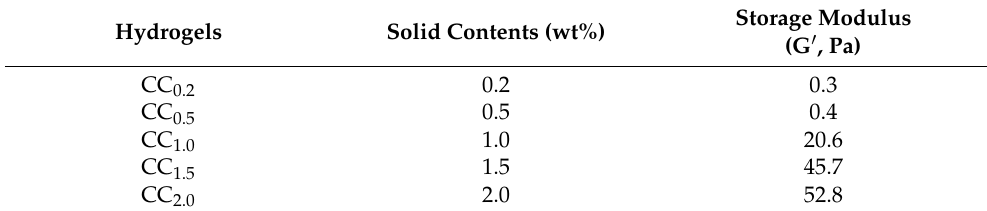
Figure 3. Rheological properties of various CC hydrogels, with solid contents of ( A ) 0.2%, ( B ) 0.5%, ( C ) 1%, ( D ) 1.5%, and ( E ) 2% at 25 °C. The storage modulus (G ′ ) and loss modulus (G ′′ ) were measured by the frequency sweep. Table 1. The storage modulus (G ′ ) at 1 Hz and abbreviated names of CC hydrogels with different solid contents.